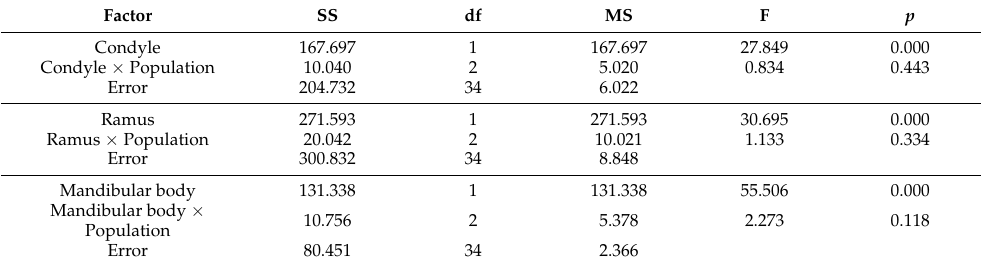
Table 4. Repeated-measures analysis of variance for adjustment of population for line measurements. Factor